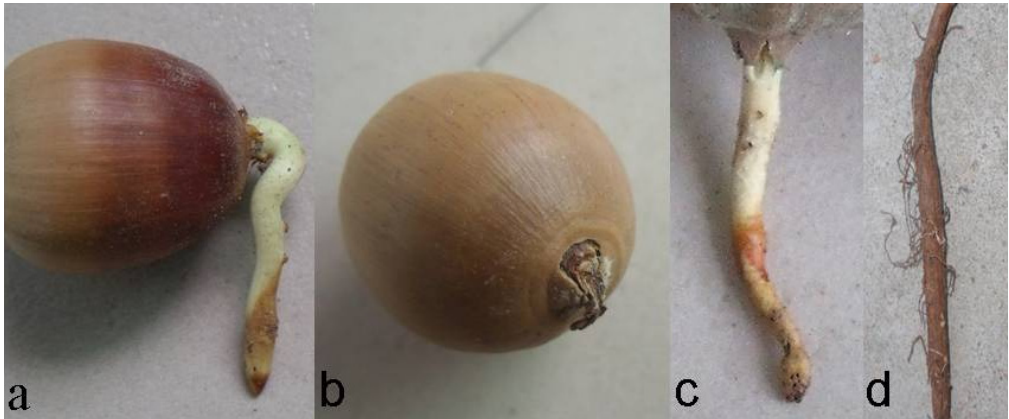
Figure 1. Development stages of radicles and radicles ‐ excision by rodents: ( a ) germinated acorn; ( b ) the acorn with a radicle-excision by rodent; ( c ) un-lignified radicle stage (ULRS); ( d ) lignified ( b ) the acorn with a radicle ‐ excision by rodent; ( c ) un ‐ lignified radicle stage (ULRS); ( d ) lignified radicle radicle stage stage (LRS).